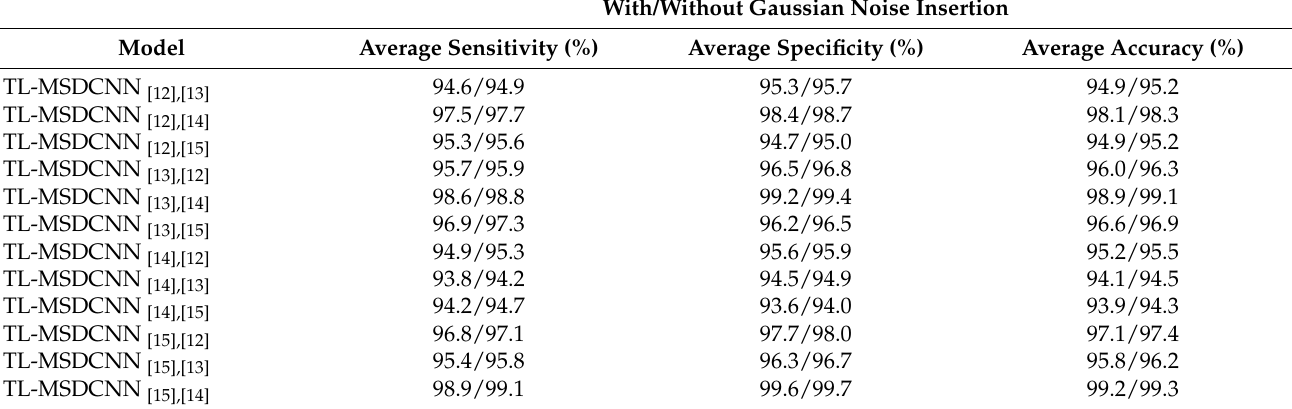
Table 3. Performance of the 12 target models using TL-MSDCNN with and without Gaussian noise